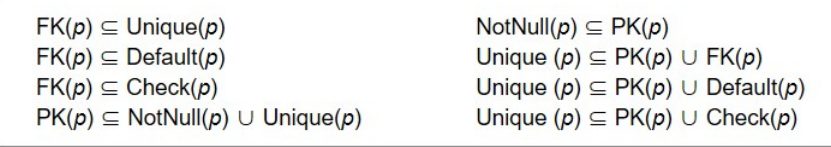
Figure 8. Subset relationships by mapping rules of integrity constraints.